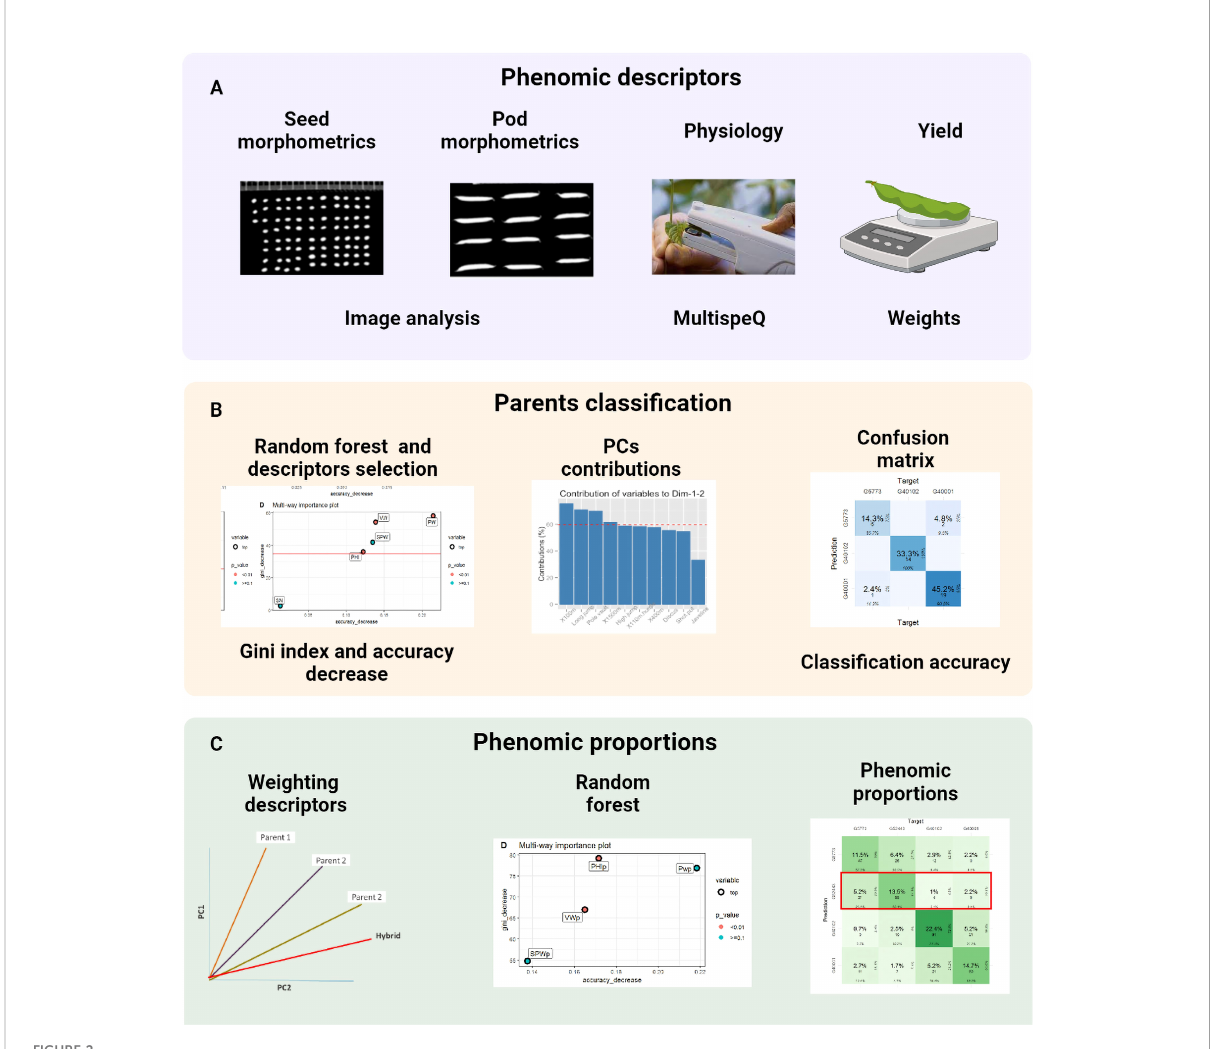
FIGURE 2 The procedure consists of three steps: (A) capture and processing of phenomic descriptors, (B) classi fi cation of parents using random forest and PCA and (C) phenomic ratios based on the weighting of the descriptors with the contribution of the PCs and phenomic ratios as the prediction of the hybrid with respect to its parents in the confusion table. This fi gure shows the different stages during the characterization process from data capture to data